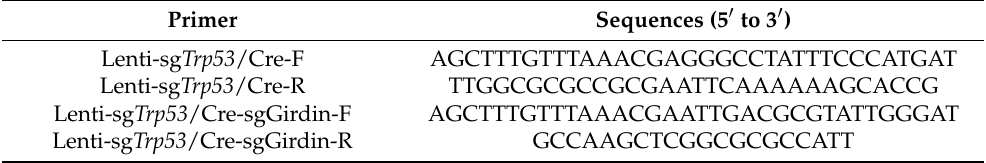
Table 1. The sequence of primers for Lenti-sgRNA/Cre plasmids.